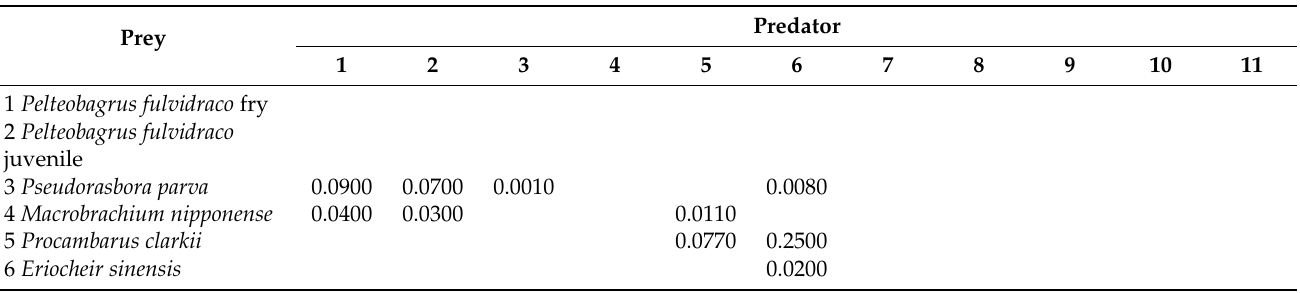
Table 1. Diet composition of the